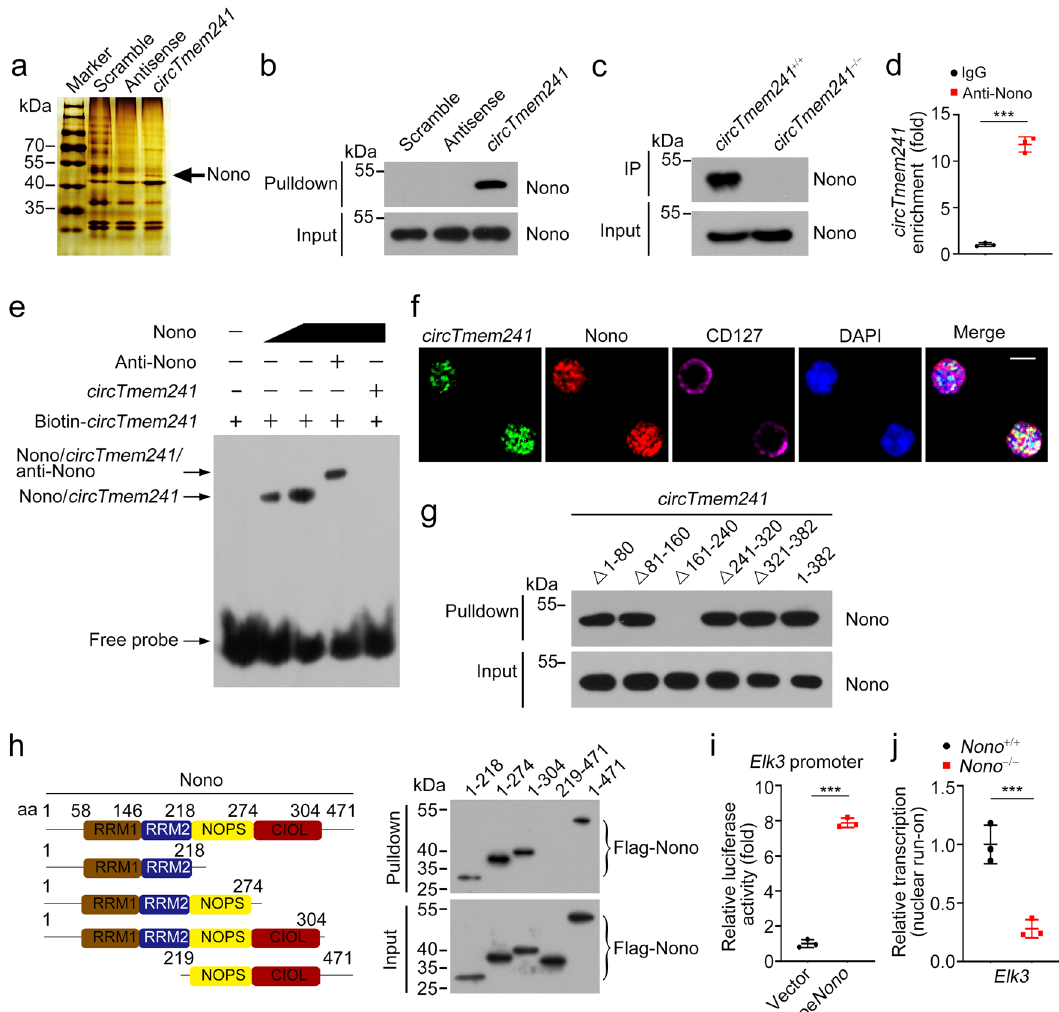
Fig.5| CircTmem241 directlyinteractswithNono.a BMcellsfromWTmicewere lysed and incubated with in vitro transcribed linear biotin-labeled circTmem241 transcripts, antisense, or scramble control. Pulldown components were separated bySDS-PAGEandfollowedbysilverstaining.Bindingproteinsof circTmem241 were identi fi ed via mass spectrometry. b BM cell lysates were incubated with cir- cTmem241 probesorcontrols,followedbyWesternblotting. c Associationbetween circTmem241 andNonowasvalidatedbyCHIRPassay,followedbyimmunoblotting. d RNA immunoprecipitation (RIP) assay was conducted using anti-Nono antibody or IgG through BM cell lysates and circTmem241 enrichment was detected by qRT- PCR. n =3foreachgroup. e EMSAwasperformedusingbiotin-labeled circTmem241 transcripts and recombinant Nono proteins with or without anti-Nono antibody. f CircTmem241 wascolocalizedwithNonoinILCPsbyimmuno fl uorescencestaining